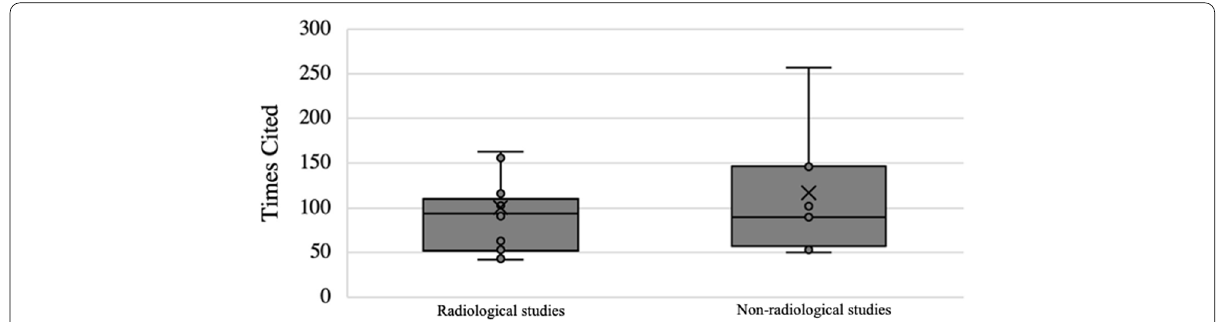
Fig. 7 Boxplot diagram and mean citations of radiological and non‑radiological